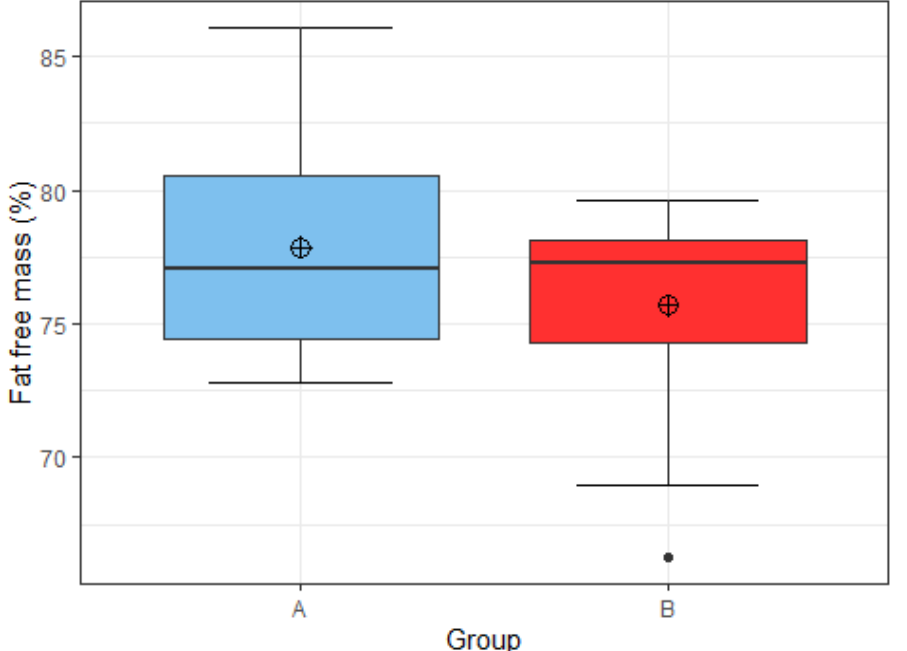
Figure 18. Distribution of percentage of lean body mass by group A ( n = 8) and group B ( n = 15). Group A: appropriate intake of protein and carbohydrate. Group B: inappropriate intake of protein or carbohydrate.